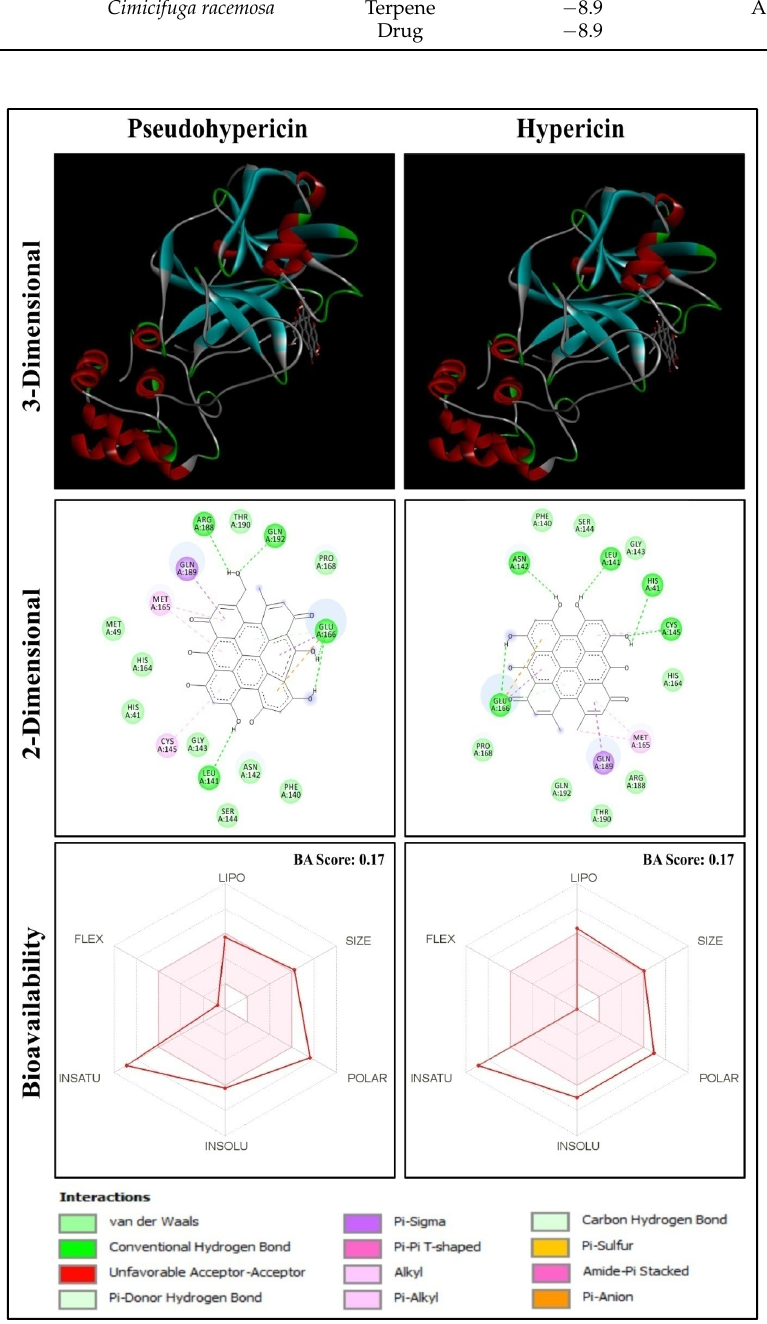
Figure 1. Anti-HIV compounds Pseudohypericin and Hypericin docked with M pro of